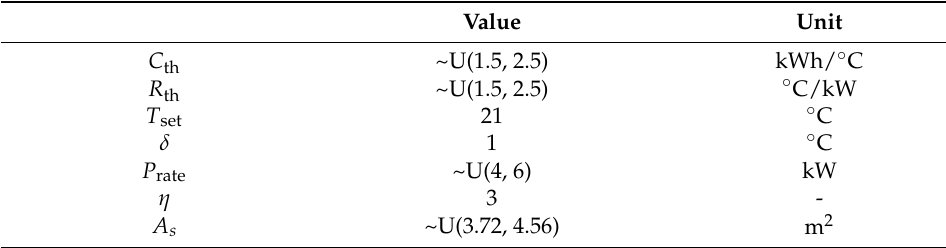
Figure 3. Outdoor air temperature profiles [25]. Table 3. ACL simulation parameters.